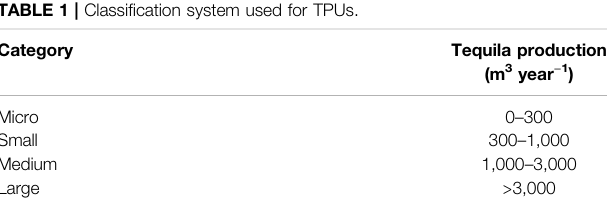
TABLE 1 | Classi fi cation system used for